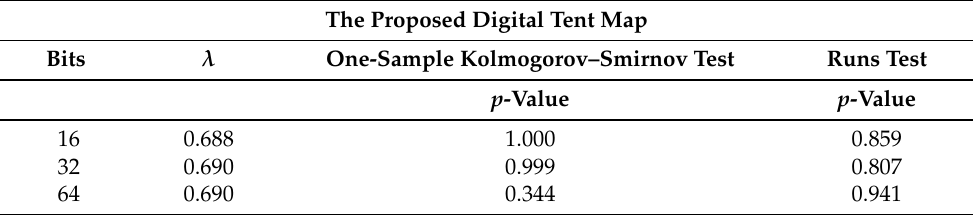
Table 4. Quantitative results to show the chaotic nature and randomness of the proposed digital